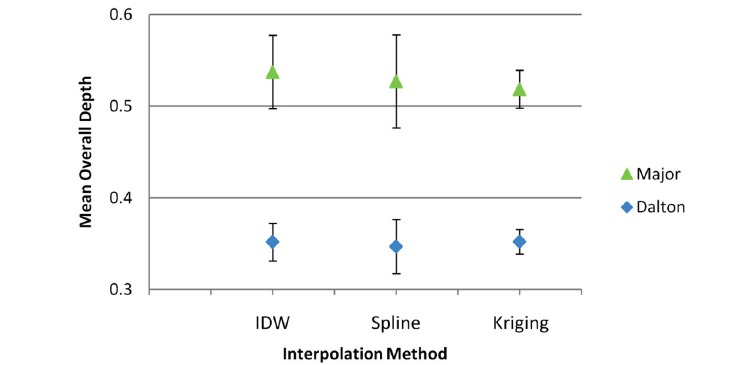
Figure 3. Mean sediment depths of all data interpolated from two Black Hills lakes. Error bars are 95% confidence